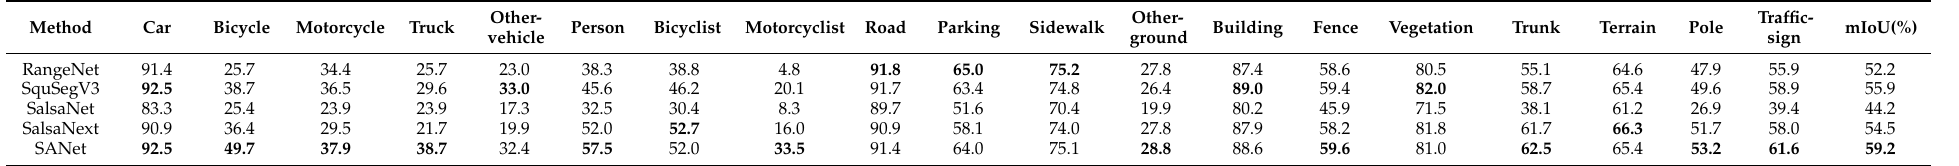
Table 1. Quantitative comparison of mIoU scores on SemanticKITTI test set (sequences 11–21) of each algorithm, SANet is the proposed